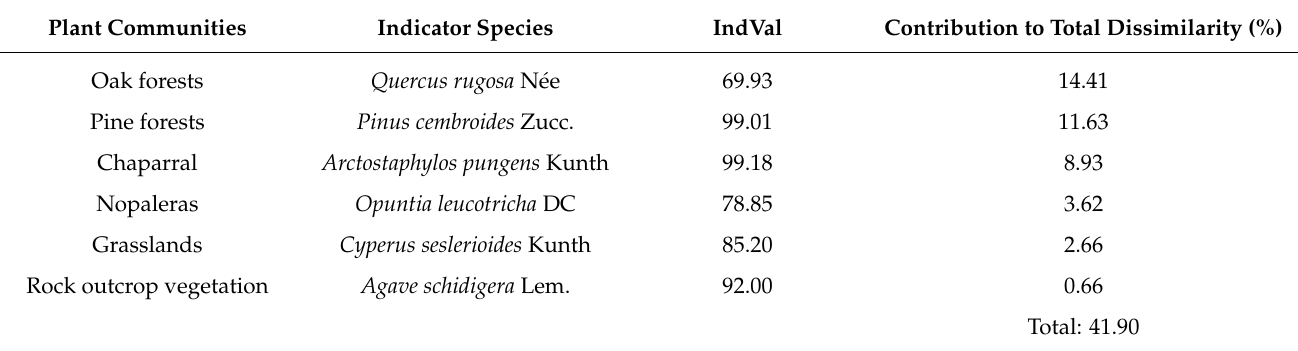
Table 2. Species with the highest IndVal value per plant community and its contribution to the total dissimilarity between communities according to the SIMPER analysis with Bray–Curtis distance